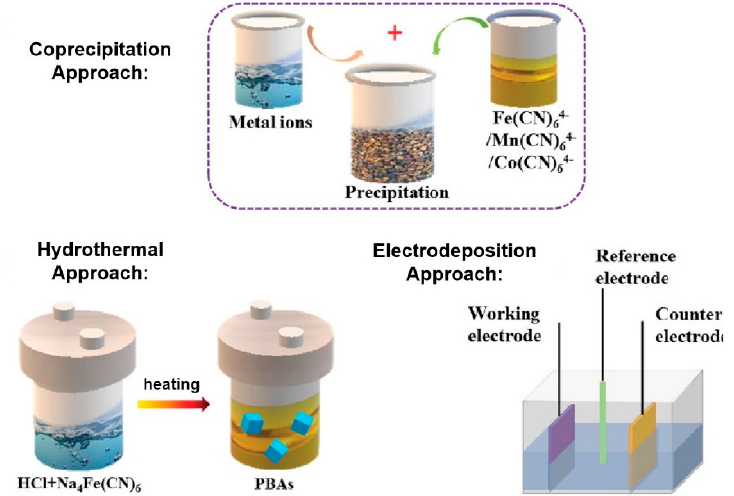
Figure 4. Schematic diagram of the preparation processes of co-precipitation, hydrothermal, and electrodeposition approaches. Adapted with permission from [9]. Copyright © 2019 WILEY.